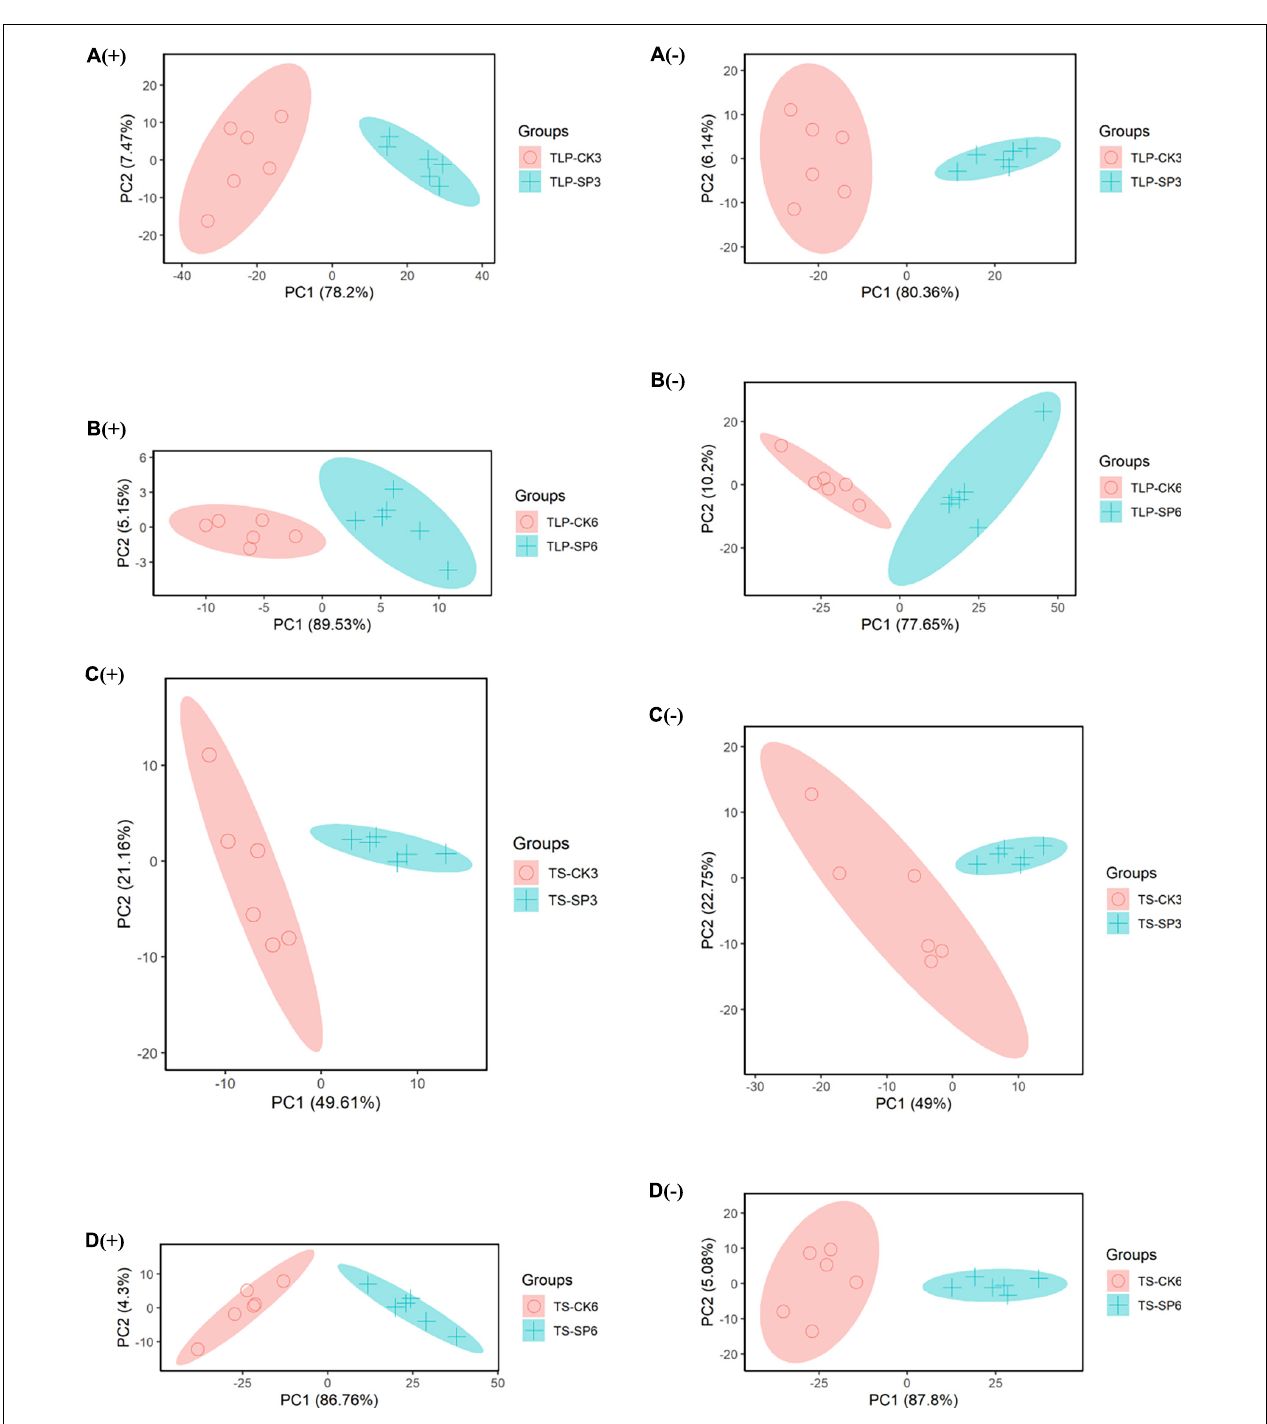
FIGURE 2 | PCA score map of different rice sample groups based on UHPLC-QTOF/MS data. (A) Rice samples of DN3 at the TLP, (B) rice samples of DN6 at the TLP, (C) rice samples of DN3 at the TS, (D) rice samples of DN6 at the TS; (+) and (–) represent positive and negative ion; TLP and TS represent three leaf period and tillering